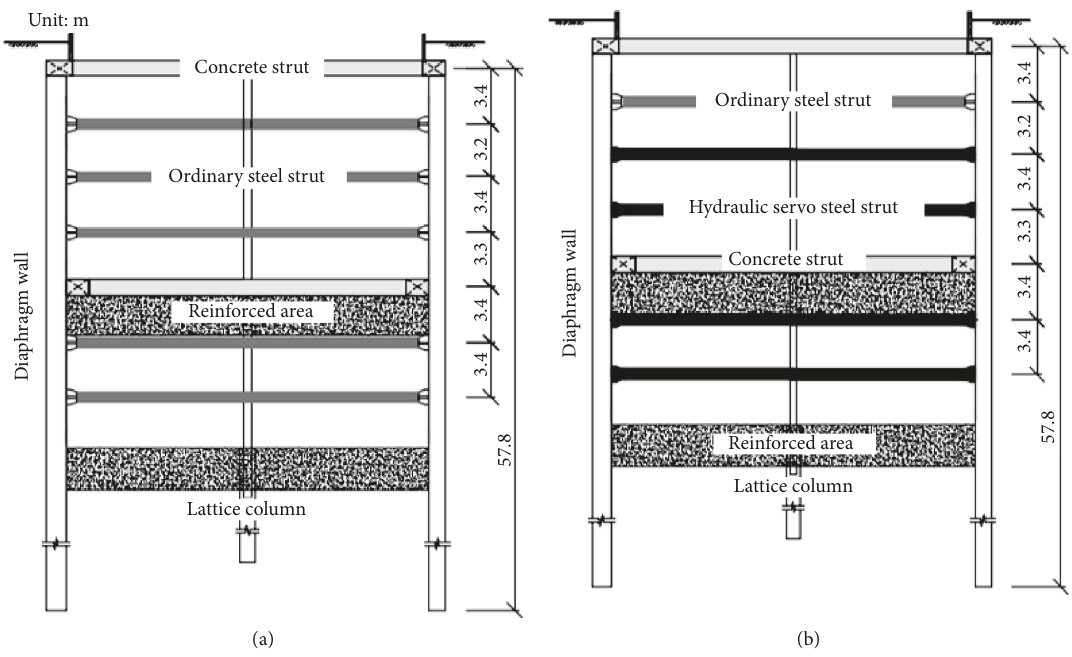
Figure 4: Cross section of the foundation pit in the standard section: (a) part 1; (b) parts 2 and